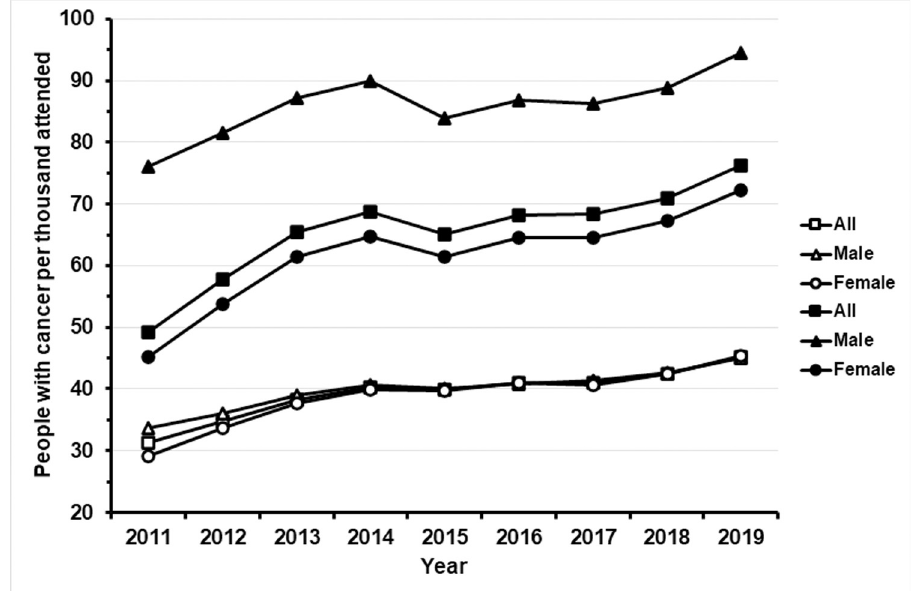
Fig 2. Frequency of cancer in the total population registered in the BDCAP database and in patients with hypothyroidism from 2011 to 2019. Data are expressed in number of people per 1,000 attended. The triangles represent the data for men, the circles those for women and squares those of patients of both sexes. The empty symbols refer to the total population, while the filled symbols represent patients with